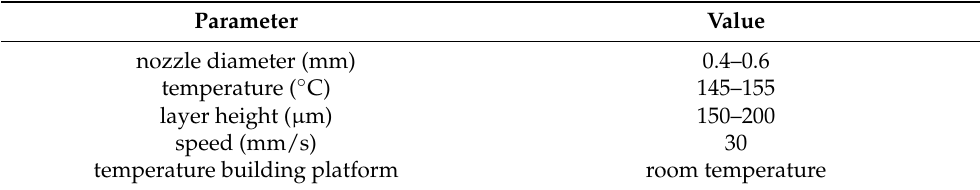
Table 1. Parameters for AM of NiTi using